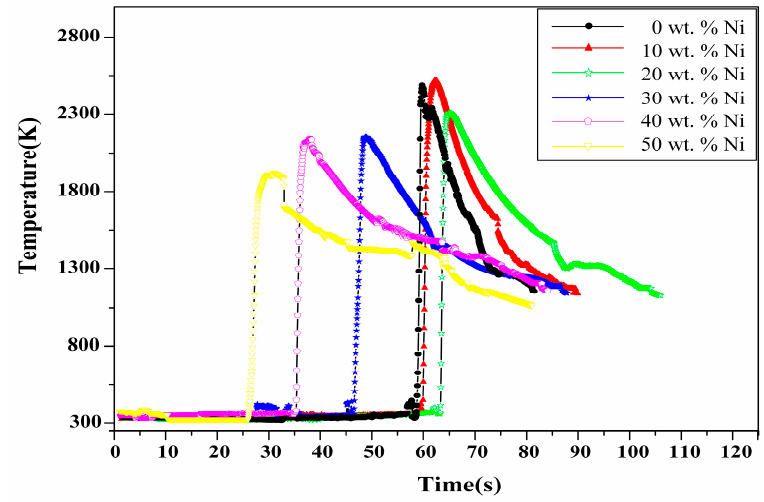
Figure 4. Time–temperature curves of the reactant compacts with various Ni contents during the SHS process.